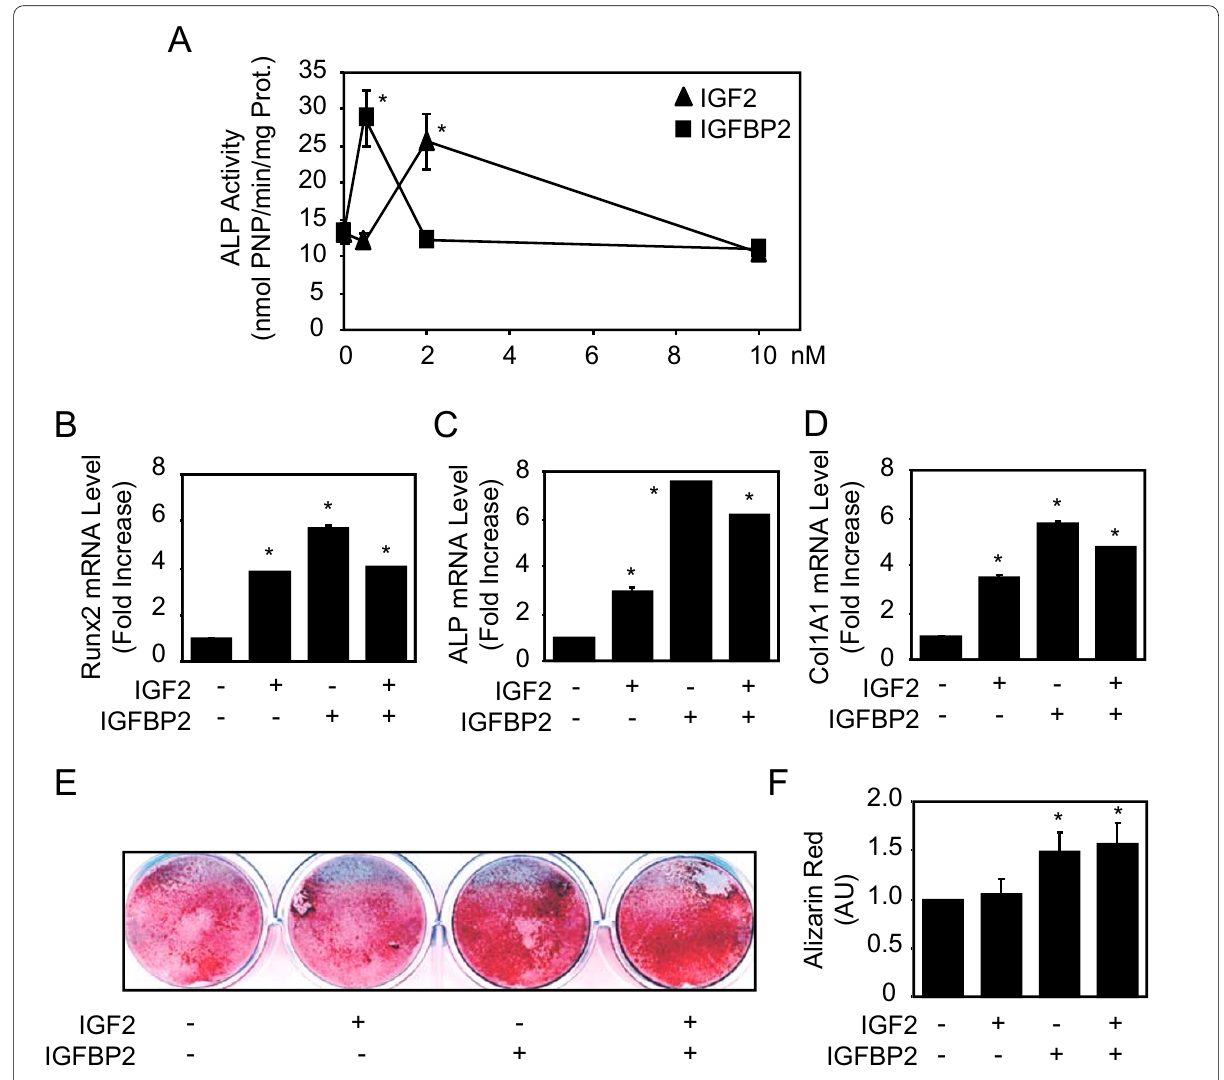
Figure 3 IGF2/IGFBP2 Promotes Human MSCs Osteogenic Differentiation . Adult hMSCs were treated with increasing concentrations of IGF2 and IGFBP2 for 4 days and alkaline phosphatase activity (ALP) was determined ( A ). Adult hMSCs were treated with or without IGF2 (2 nM) and IGFBP2 (0.5 nM) for 3 days, total RNA was collected and used for quantitative RT-PCR analysis of Runx2, ALP and Col1A1 expression ( B-D ). Adult hMSCs were cul- tured in an osteogenic differentiation medium, treated with/without IGF2 (2 nM), IGFBP2 (0.5 nM) or their combination and extracellular matrix min- eralization was evaluated by alizarin red staining ( E ) and confirmed by quantification ( F ). Results are expressed as the mean ± SD of treated over control ratio. *: significant difference with untreated cells ( P <